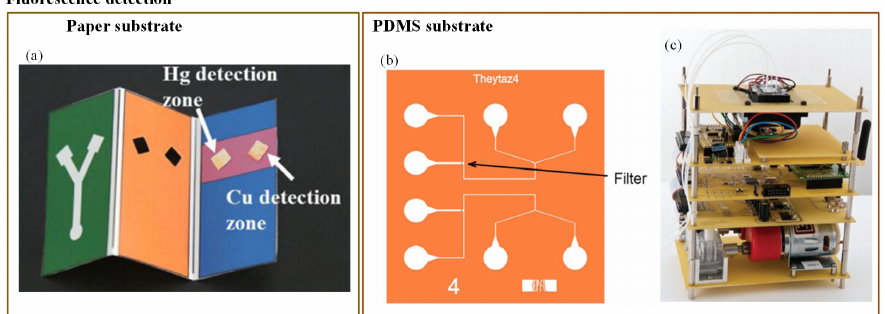
Figure 8. ( a ) Three-dimensional paper-based fluorescence detection of Cu 2+ and Hg 2+ [144]; ( b ) E. coli -based fluorescence detection of As(III) [146]; and ( c ) fluorescence detection of As(III) using portable bioreporter